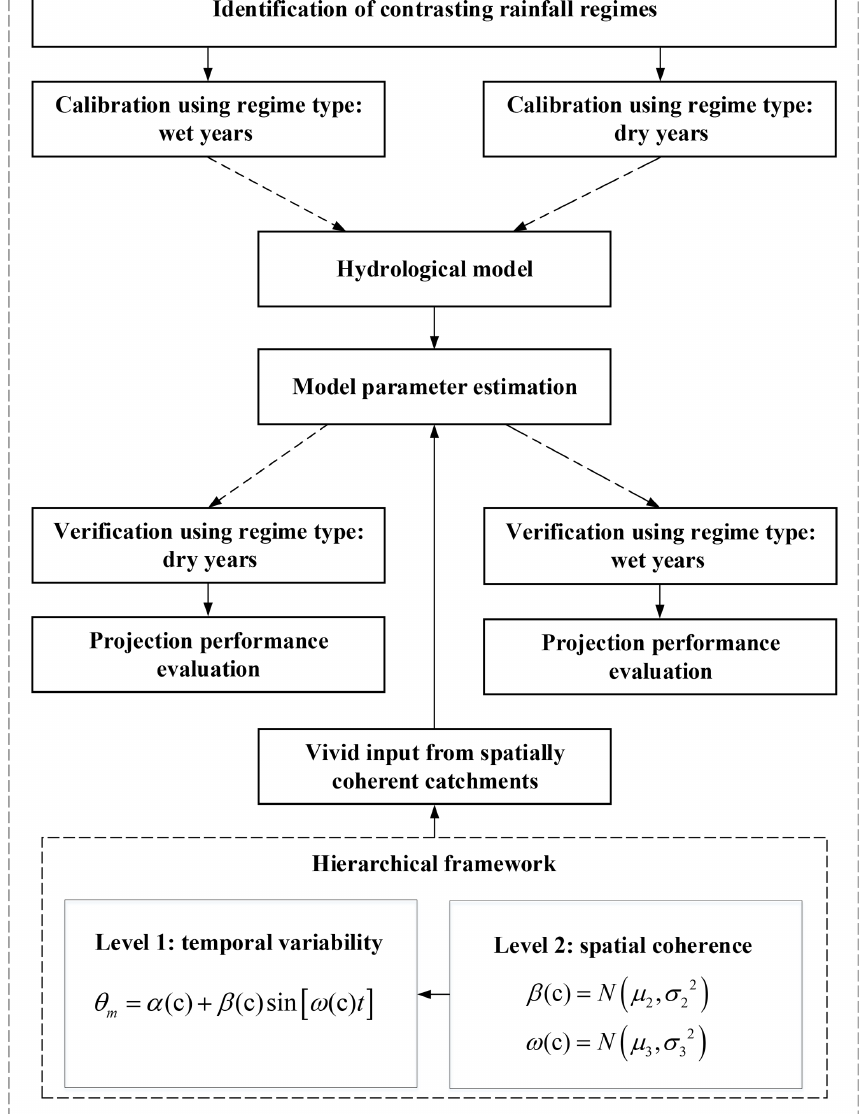
Figure 1. Flow chart of the methodology for integrating inputs from spatially coherent catchments and temporal variation of model parame- ters into a hydrological model under contrasting climatic conditions (wet and dry